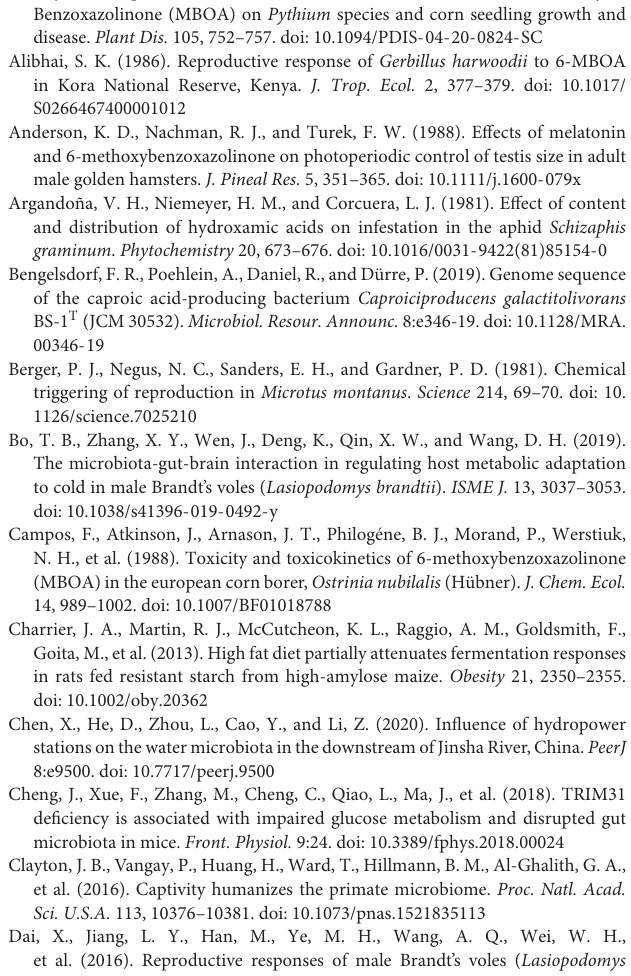
relative abundance less than 0.1%.